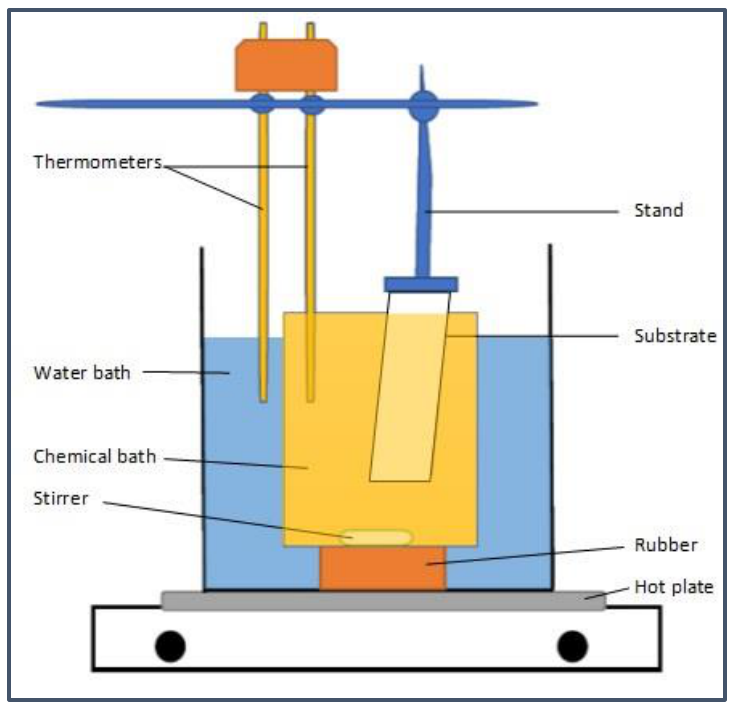
Figure 1. Experimental setup of CBD technique.